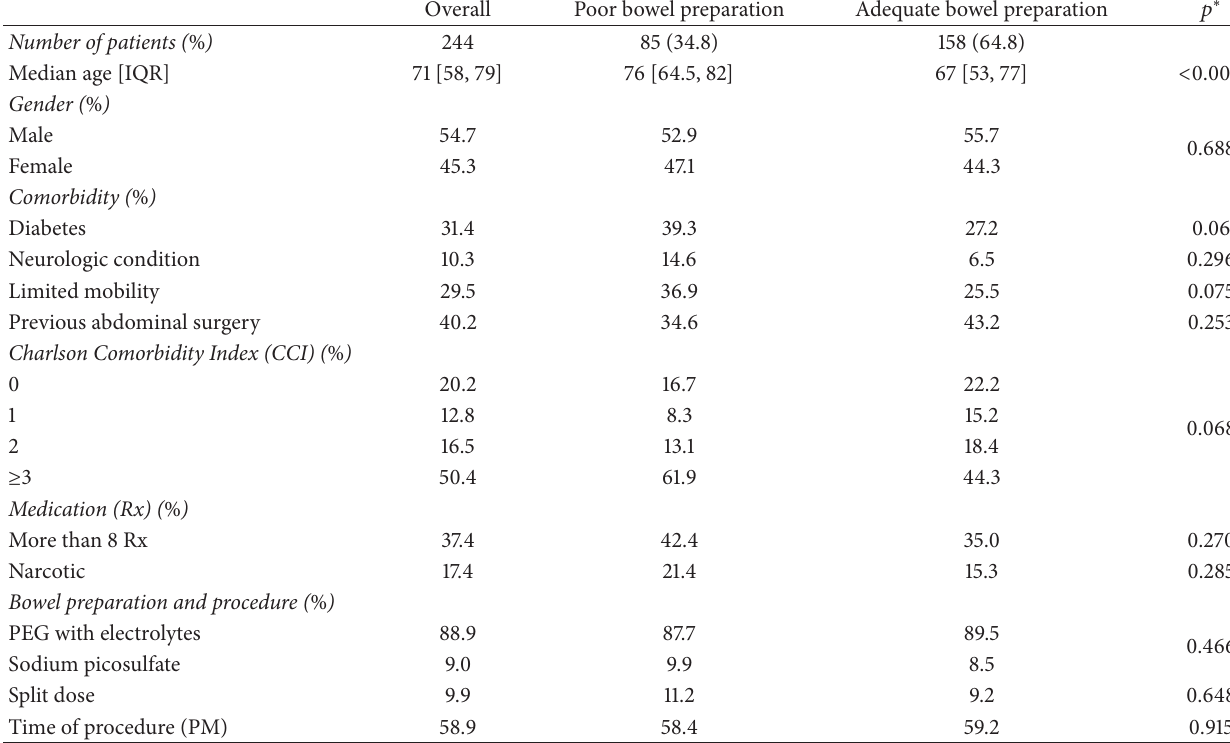
Table 1: Characteristics of patients as a function of bowel preparation.